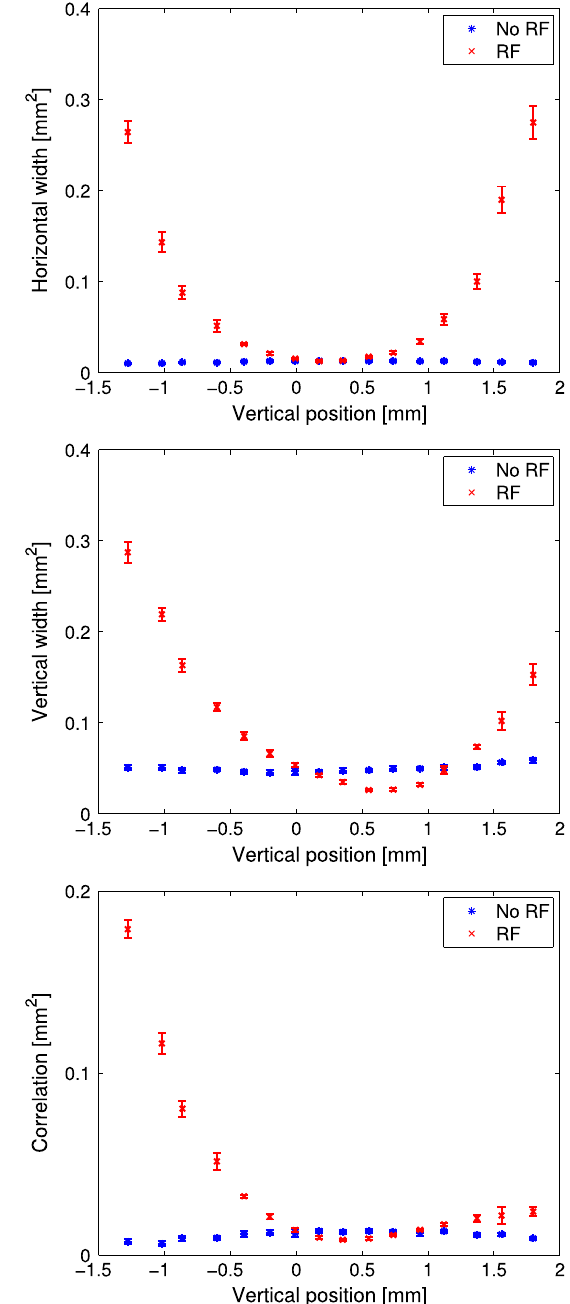
FIG. 6. Horizontal width (top), vertical width (middle) and correlation term (bottom) on screen for different vertical posi- tions. Plots show both beam with and without rf inside the ACS. The octupole field has a strong effect on the beam size on the